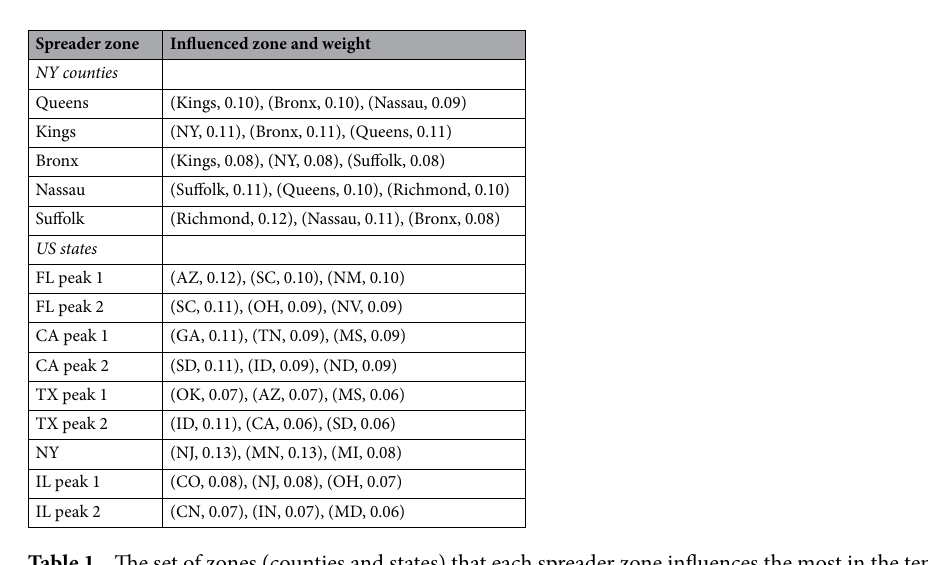
Figure 4. The 5 zones, i.e., ( a ) NY counties and ( b ) US states exhibiting the highest weighted out-degree centrality (and thereby acting as spreaders) in the temporal networks.